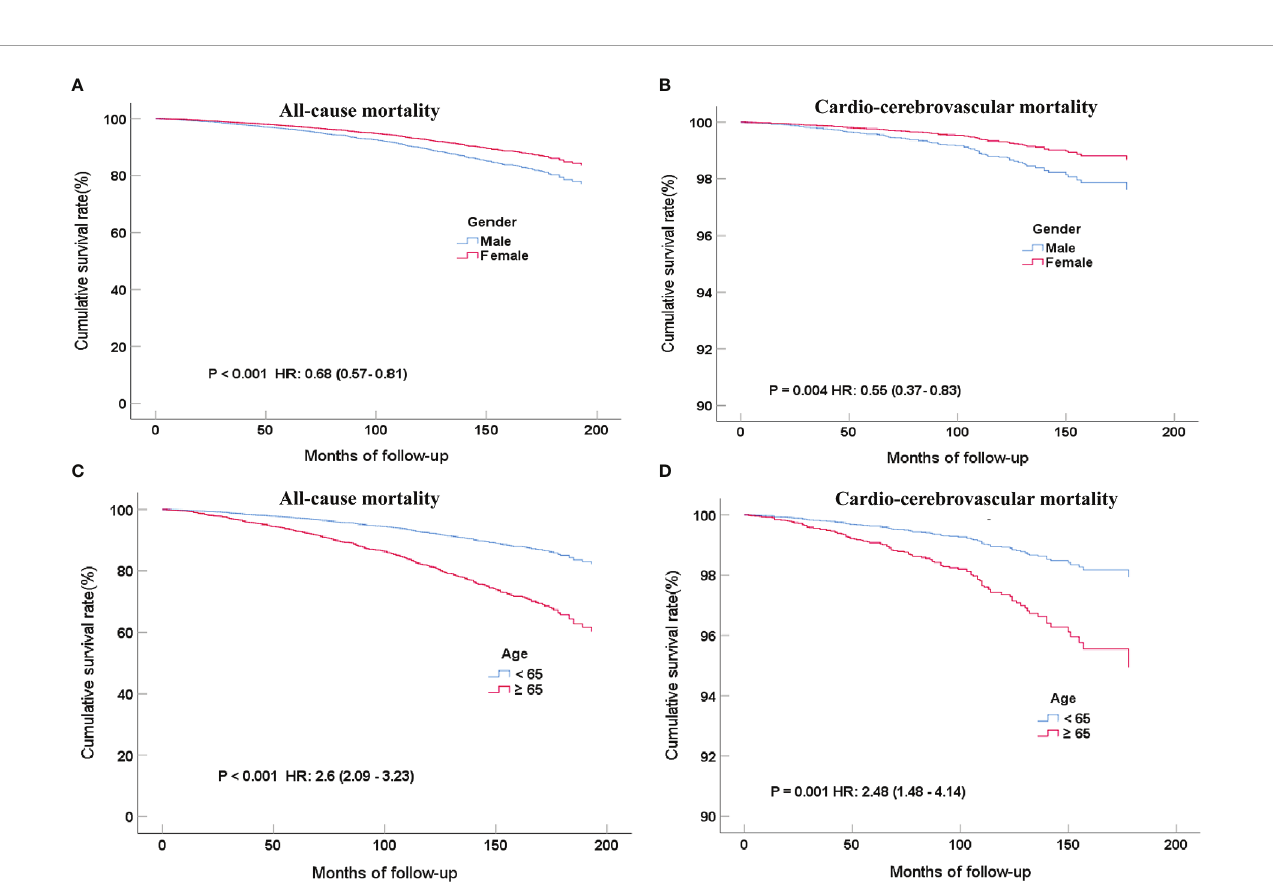
FIGURE 4 COX regression curves for all-cause (A) and cardio-cerebrovascular (B) mortality rates of MetS patients grouped by gender after multi-factor adjustment and 7.7 years of follow-up; COX regression curves for all-cause (C) and cardio-cerebrovascular (D) mortality rates of MetS in different age groups after multi-factor adjustment and 7.7 years of